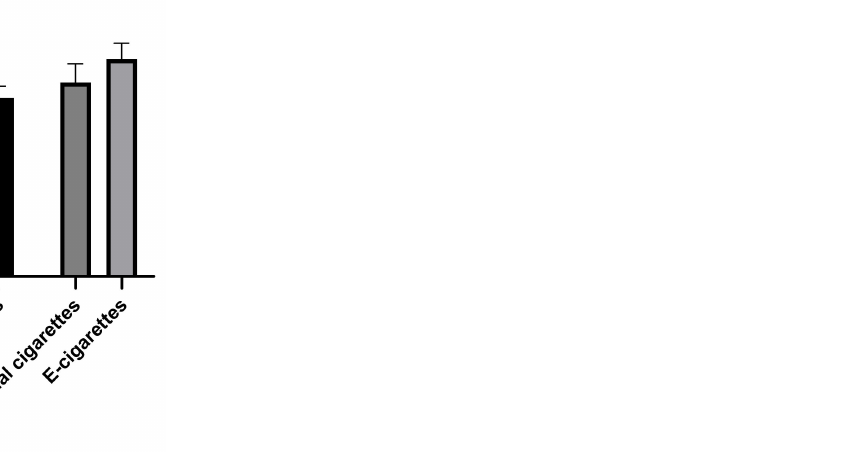
Figure 1. Concentration of uric acid in groups of e-cigarettes users, traditional cigarettes smokers and